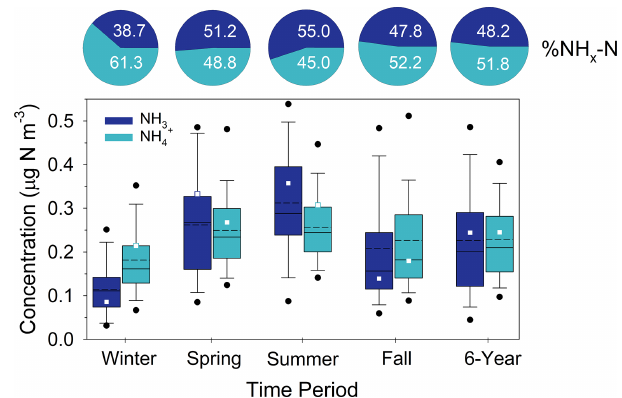
Figure 7. Summary of AMoN NH 3 and CASTNET NH + concen- 4 trations (as N) from 2015–2020 during winter, spring, summer, and fall. Solid and dashed lines inside the box represent the median and mean, respectively. The top and bottom of the box represent 75th and 25th percentiles. Whiskers represent 10th and 90th percentiles, and dots represent 5th and 95th percentiles. “6-year” represents the statistics for the entire 6-year period. Squares represent the seasonal and annual mean concentration for the August 2015–August 2016 modeling period. Pie charts represent the average percent contribu- tion of NH 3 and NH + to total NH x (NH 3 + NH + ) expressed as 4 4 nitrogen. AMoN concentrations were adjusted by subtracting the mean travel blank for the 6-year period.